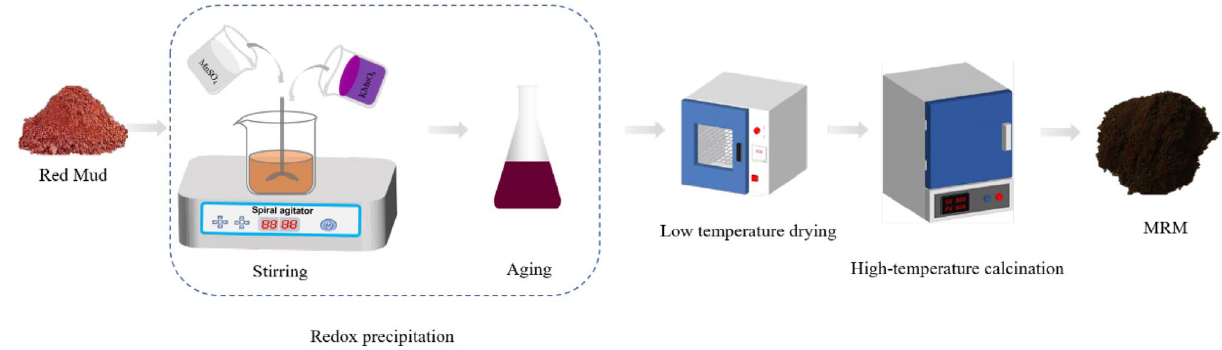
Figure 18. Preparation process of modified red